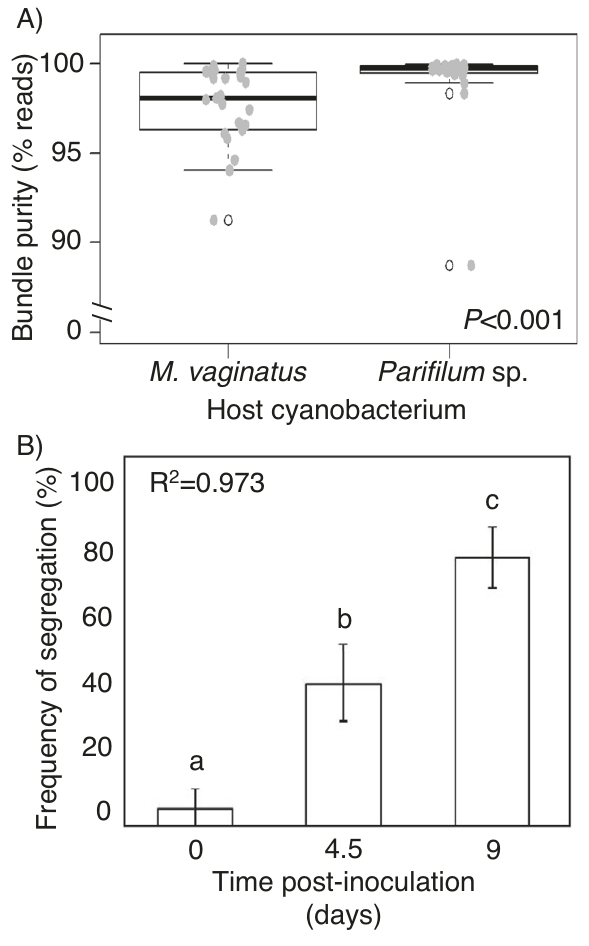
Fig. 2 Self-segregation of pioneer cyanobacteria in natural bundle populations and culture segregation assays. A Boxplot of the proportion of cyanobacterial reads contributed by the dominant cyanobacterium in each bundle community. B Observed frequen- cies of segregation in mixed populations of M. vaginatus PCC9802 and P. solicrustae SON57 over 9 days ( n = 300 observations per timepoint). Frequencies of segregation increased linearly and were signi fi cant at each timepoint according to non-parametric Kruskal- Wallis with Dunn post-hoc tests ( P < 0.0005 for